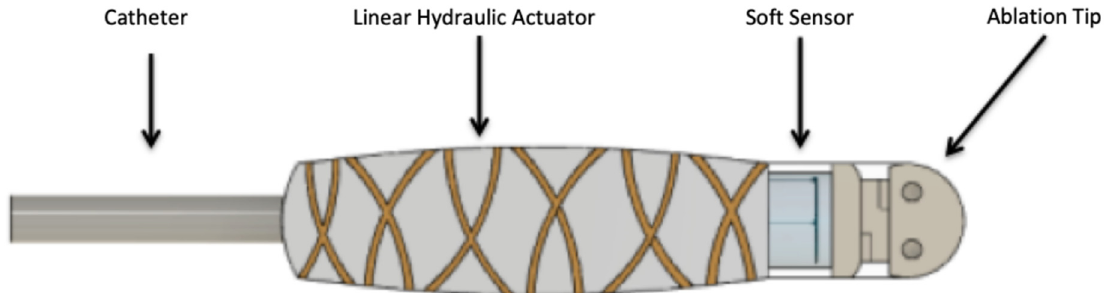
Figure 1. A 2D rendered image of a soft linear actuator intended for cardiac catheter ablation described in [18]. The soft device consists of a linear hydraulic actuator that can be pressurized using inert saline solution pumped in through the catheter line. The fibers wrapped around the actuator allow for only one degree of freedom when pressured, so the device can extend and retract perpendicular to the heart wall. The soft sensor that will be expanded on in this paper will be housed in line with the ablation tip in order to accurately output the compressive force experienced by the ablation tip during contact with cardiac tissue. The electrodes and wiring normally associated with radio-frequency ablation is not shown in this theoretical portrayal.